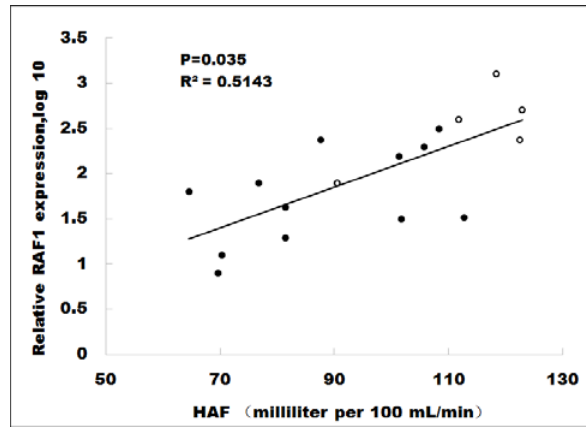
Figure 5: HAF value correlates with the RAF1 expression. Logis- tic regression showed a significantly positive linear correlation between HAF values and RAF1 expression levels. Moreover, the sorafenib-resistant samples (blue dots) demonstrated higher levels of HAF and RAF1 expression.